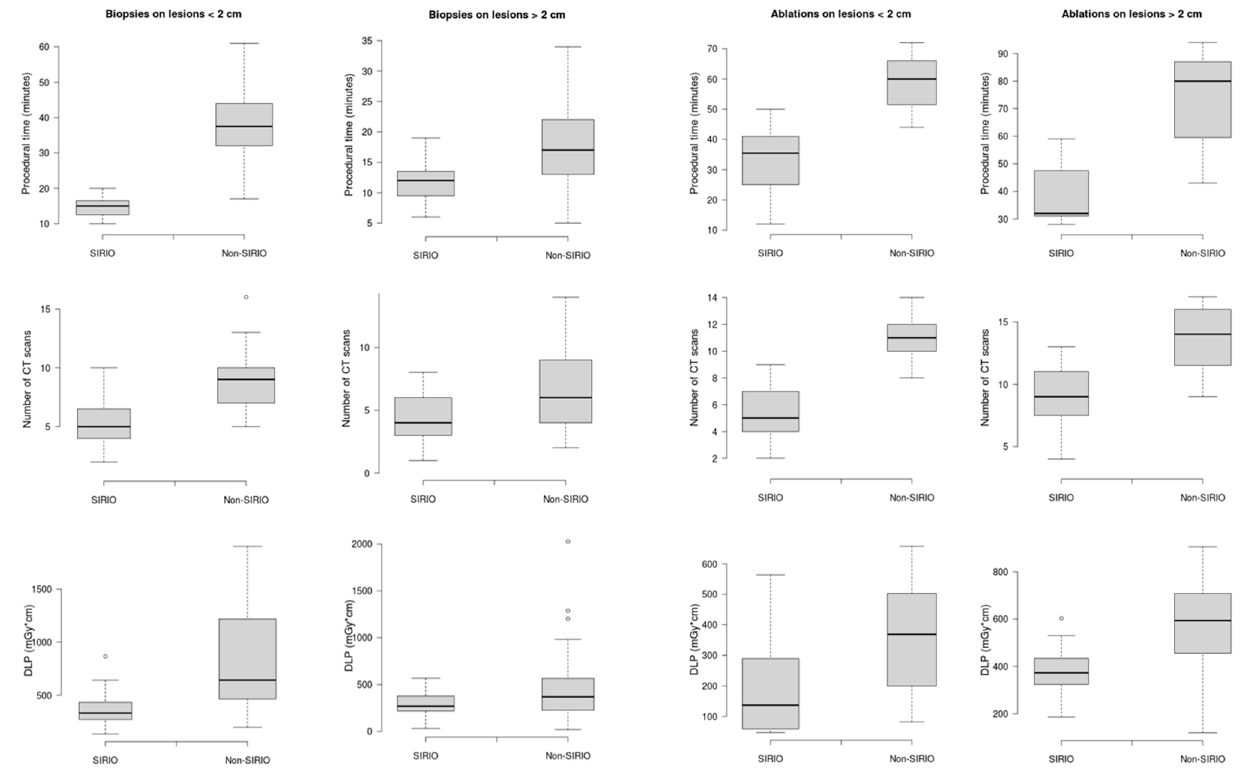
Figure 4. Boxplot graphs showing the differences between procedures performed using SIRIO and standard CT-guidance